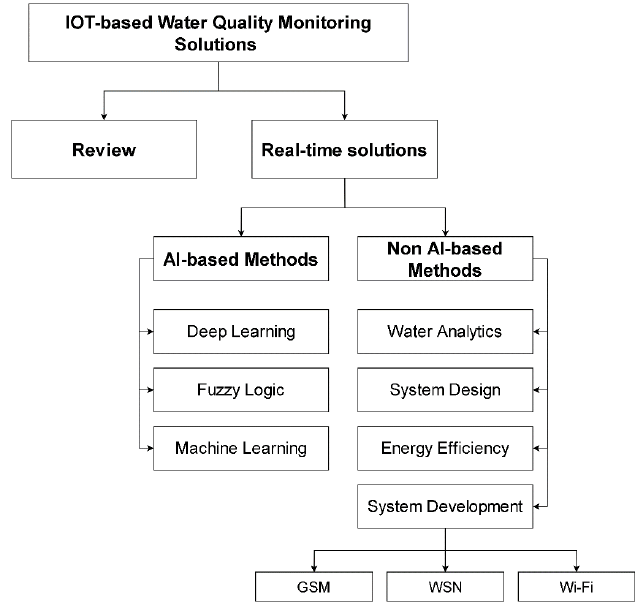
Figure 2. The taxonomy of the